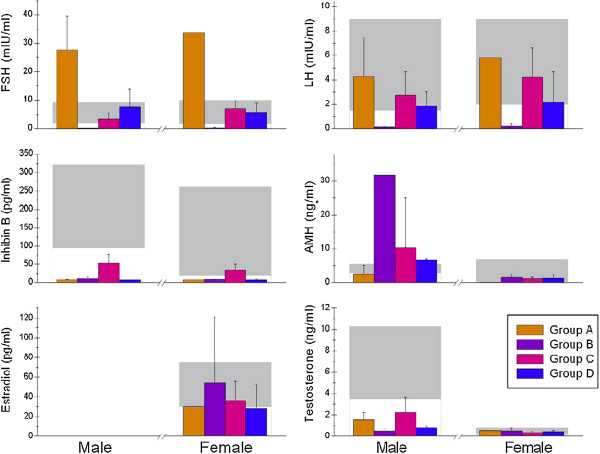
Serum levels of LH, FSH, AMH and inhibin B (INB) in the four groups of PWS males and females, serum estradiol levels in females and testosterone levels in males. Group A: primary hypogonadism; Group B: central hypogonadism; Group C: partial gonadal & central dysfunction; Group D: mild central and severe gonadal dysfunction. Criteria for classifying patients in each group according to inhibin B and FSH levels are described in “Results.” The grey bars represent the normal ranges. Among the 4 groups P < 0.0001 for the differences in FSH and INB, P < 0.001 for the differences in LH and P < 0.01 for AMH. Among the males, P < 0.0001, P < 0.03 and P < 0.01 respectively for INB, testosterone and AMH. Among the females, P < 0.001 for INB (ANOVA).